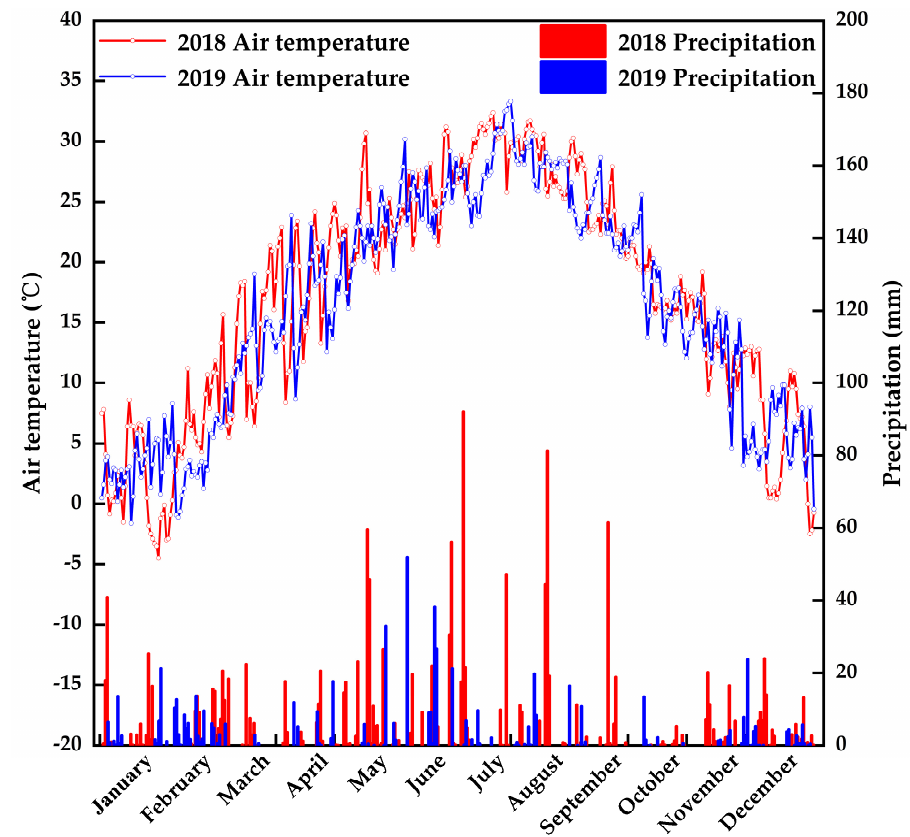
Figure 2. Air temperature ( ◦ C) and precipitation (mm) in 2018 and 2019. Table 1. Chemical properties of the soil at the study